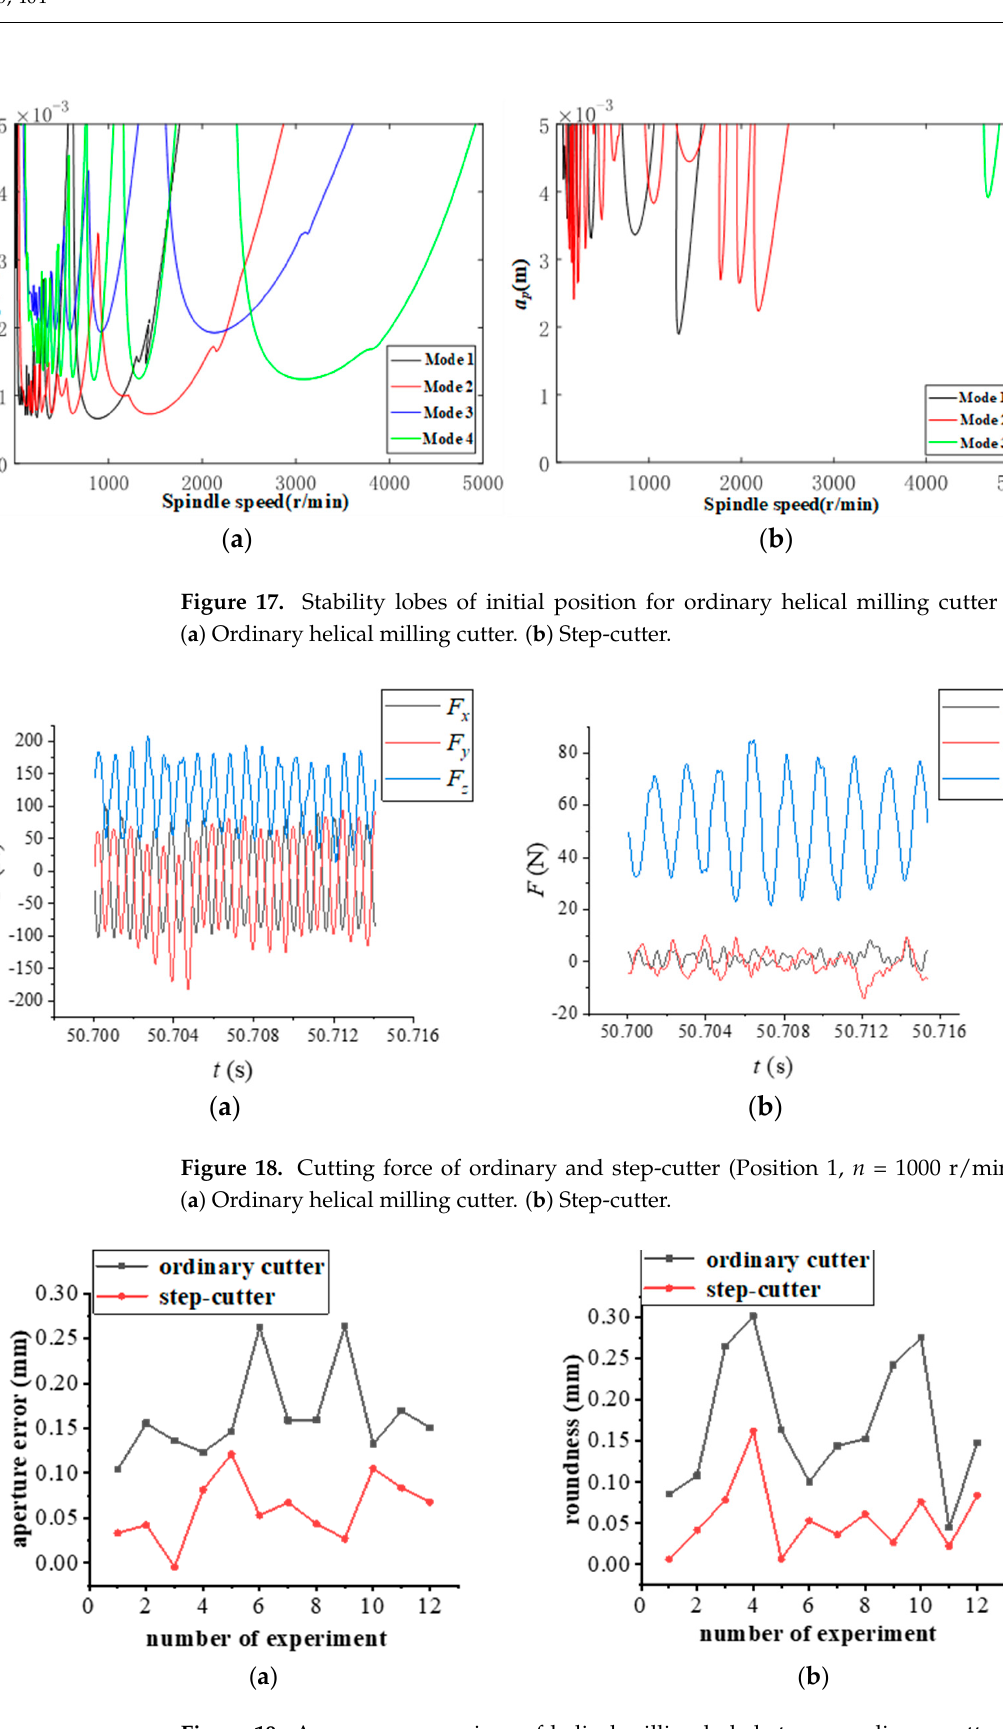
( b ) Figure 19. Accuracy comparison of helical milling hole between ordinary cutter and step-cutter. ( a ) Aperture error. ( b ) Roundness. In order to verify that the step-cutter can effectively improve the quality of the ma- chined surface, the roughness of the inner wall of the hole at different rotational speeds at the same location was measured using a roughness measuring instrument and compared with the roughness of the inner wall of the hole diameter machined with an ordinary cut- ter, as shown in Figure 20.